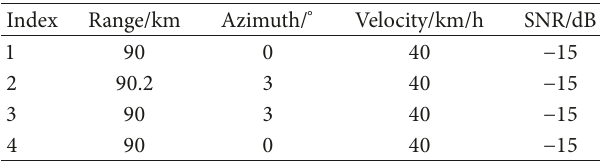
Table 2: Simulated target